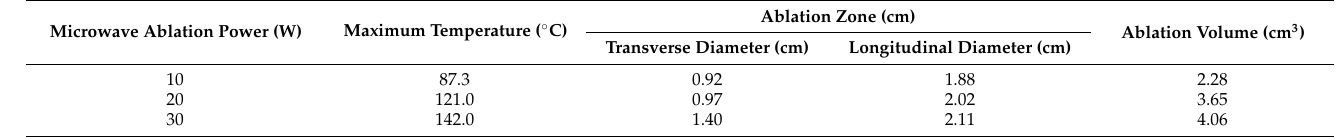
Table 7. Ablation temperature, ablation area and ablation volume at different ablation